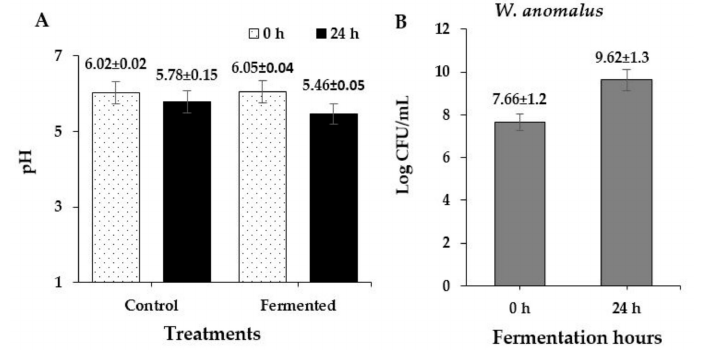
Figure 1. The pH in yeast inoculated and non-inoculated treatments ( A ) and yeast population ( B ).